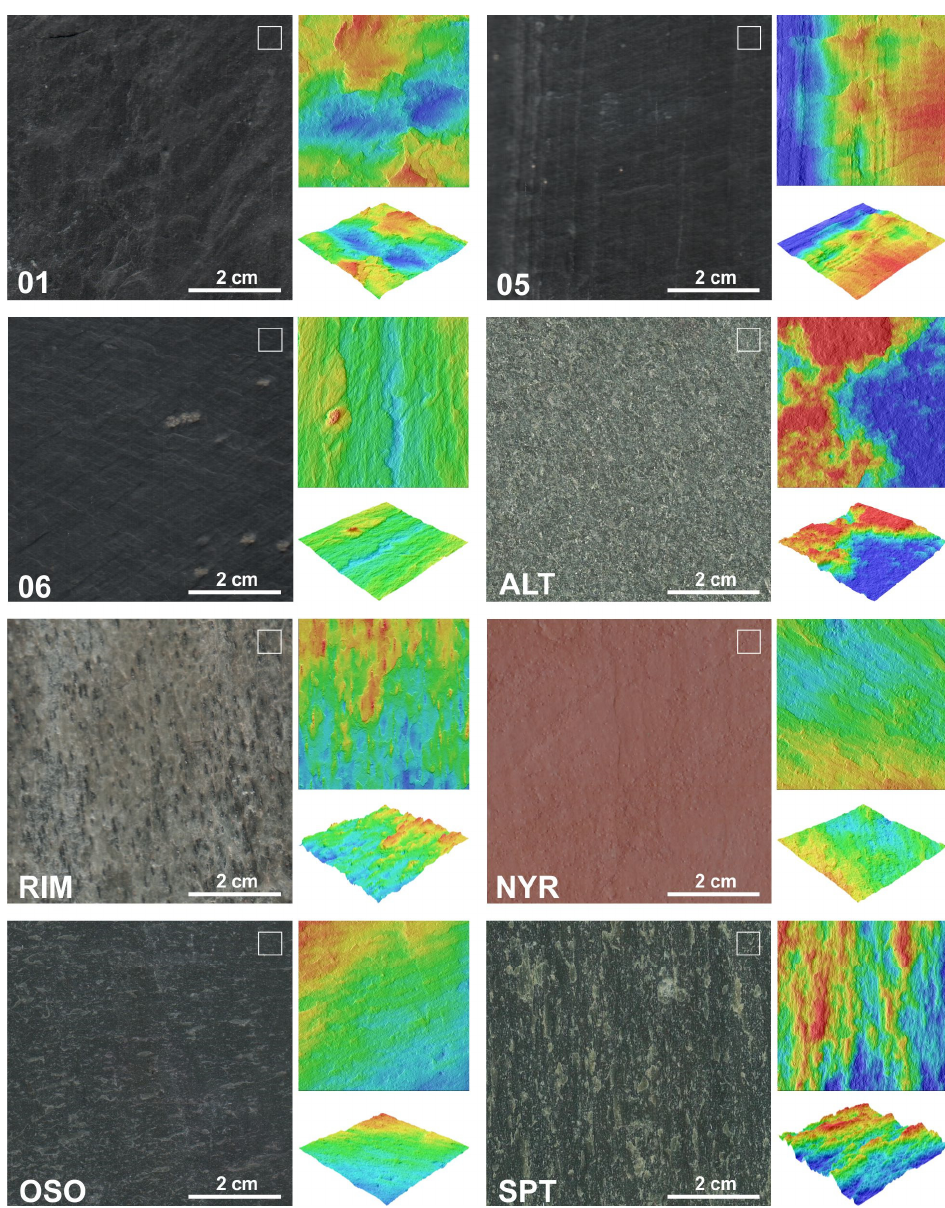
Figure 5. Macro aspect and laser roughness scan of some of the samples. The small white square in the upper right corner of each macro image represents the area scanned in the surface-roughness laser measurement. The vertical scale is the same for all the samples in the roughness renderings (between − 500 µm (blue) and +500 µm (red)). Samples 01, 05, ALT, and SPT have greater differences in height than 06, RIM, NYR, and OSO.